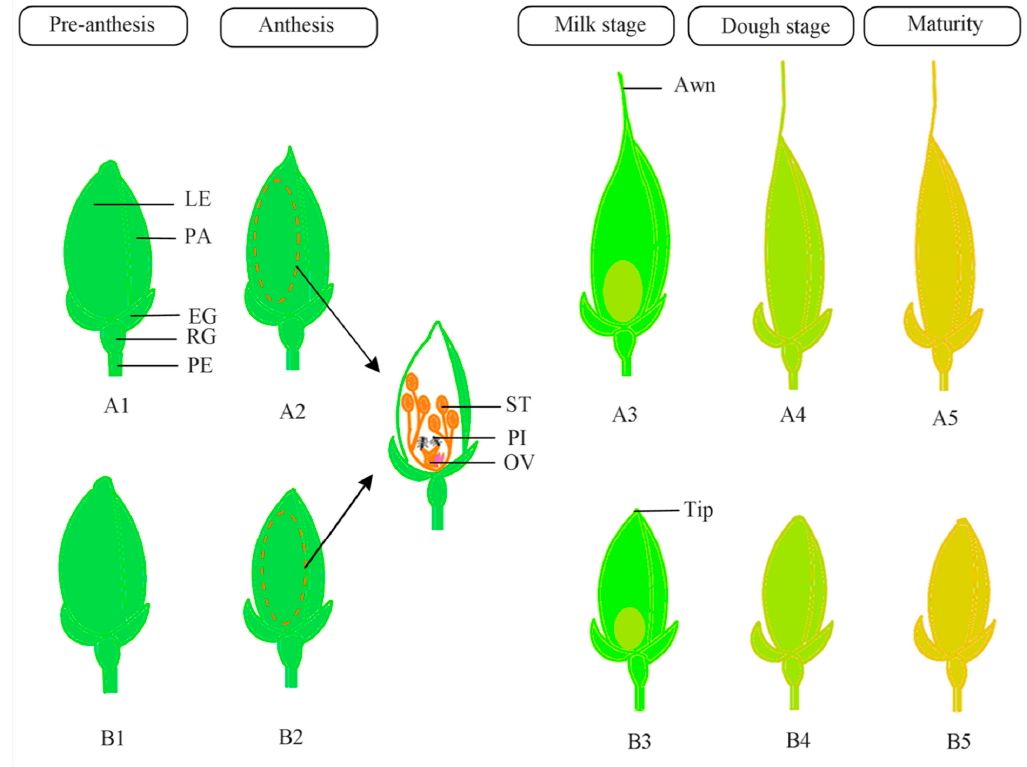
Figure 2. A generalized diagram of awn development in rice. From heading to a few weeks before anthesis, awned and awnless spikelets show similar growth. During the anthesis, reproductive organs differentiate and awned spikelets show higher growth than awnless spikelets. During the milk stage, the grain starts to develop, and the awn elongates in the awned spikelet, whereas the awnless spikelet forms a round tip. During the dough and maturity stages, the awn photosynthetic activity drops, the spikelet decreases in volume, and the awned plant provides a longer and larger seed than the awnless spikelet. EG, empty glume; LE, lemma; OV, ovary; PA, palea; PE, pedicel; PI, pistil; RG, rudimentary glume; ST,